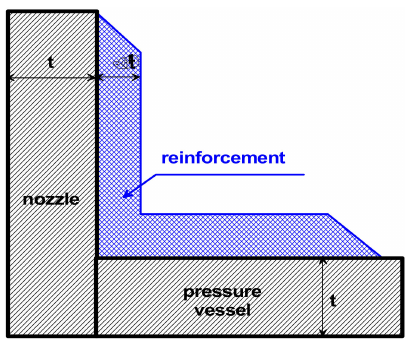
Figure 9. Schematic view of reinforcement—the longitudinal cross-section.